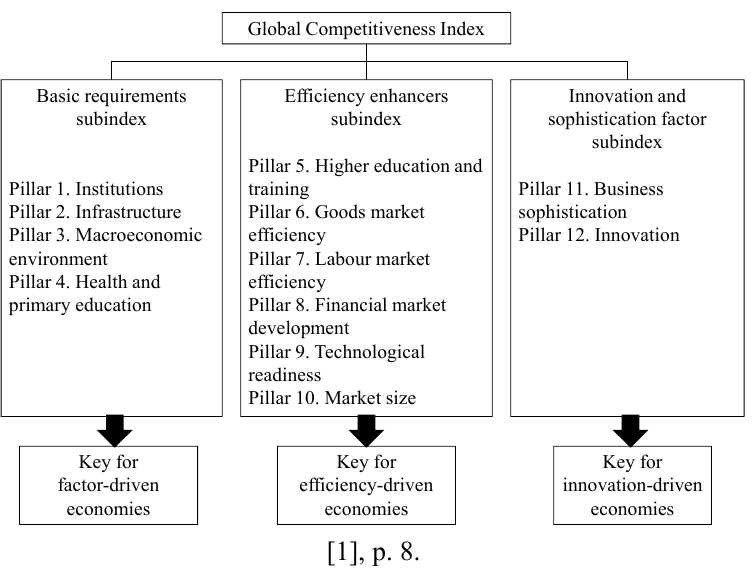
Figure 1. The Global Competitiveness Index